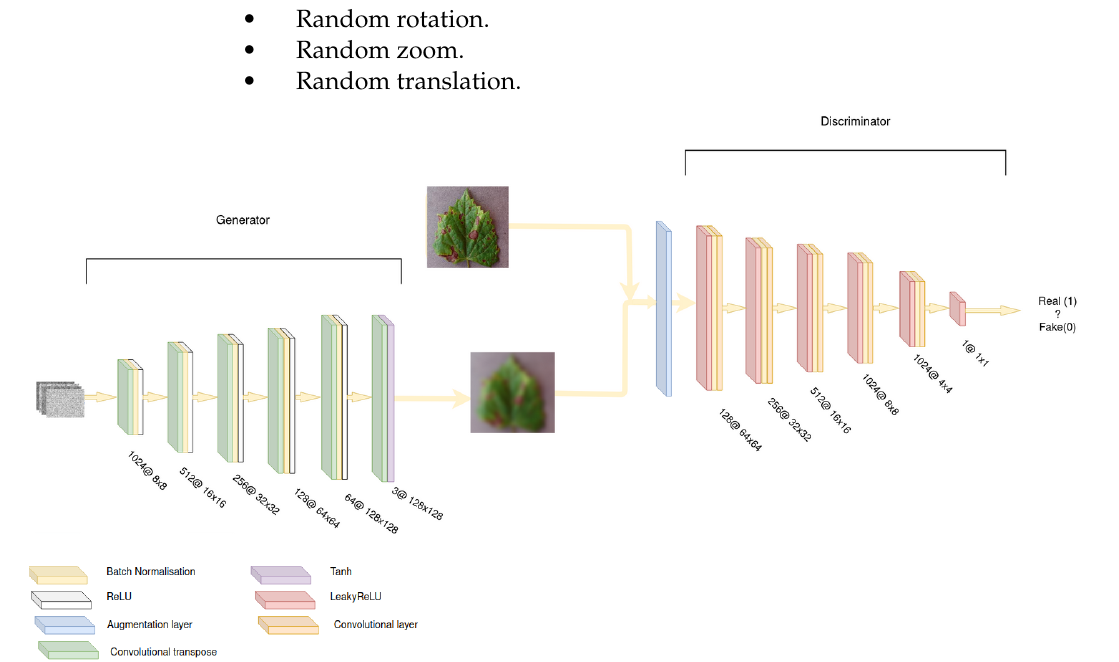
Figure 3. Proposed GAN